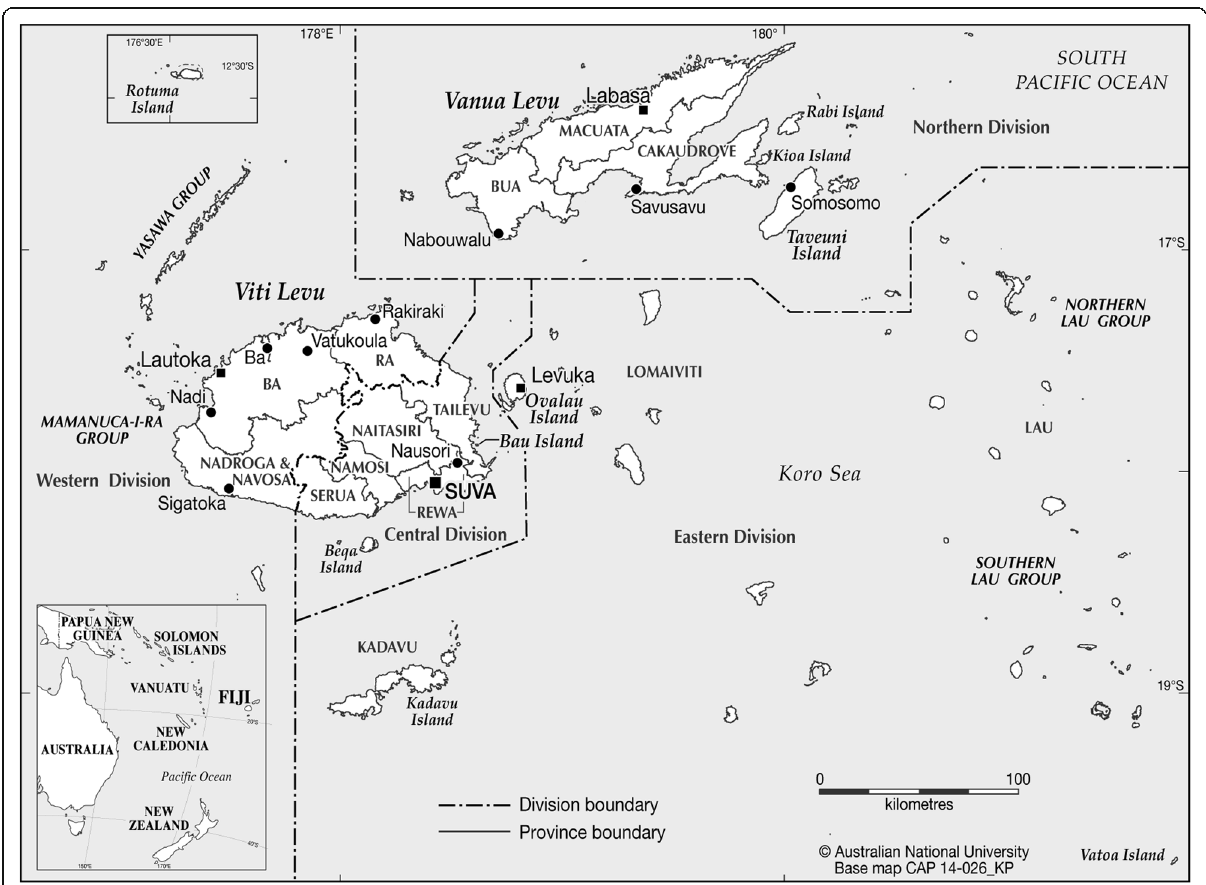
Fig. 1 Map of Fiji with division and subdivision (province) boundaries. Source: Fraenkel (2015) Journal of Pacific History 2015 DOI: 10.1080/ 00223344.2015.1013598, with permission. Map produced by CartoGIS Services, ANU College of Asia and the Pacific, Australian National University (reproduced with